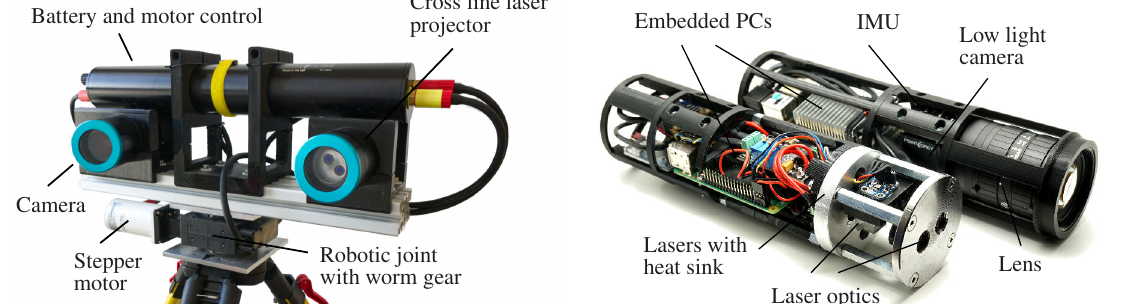
Figure 4. Structured light underwater laser scanner. Left: Scanner with motorized robotic joint mounted on a tripod, right: Detail view of the camera and laser projector assemblies mounted inside the underwater housings.